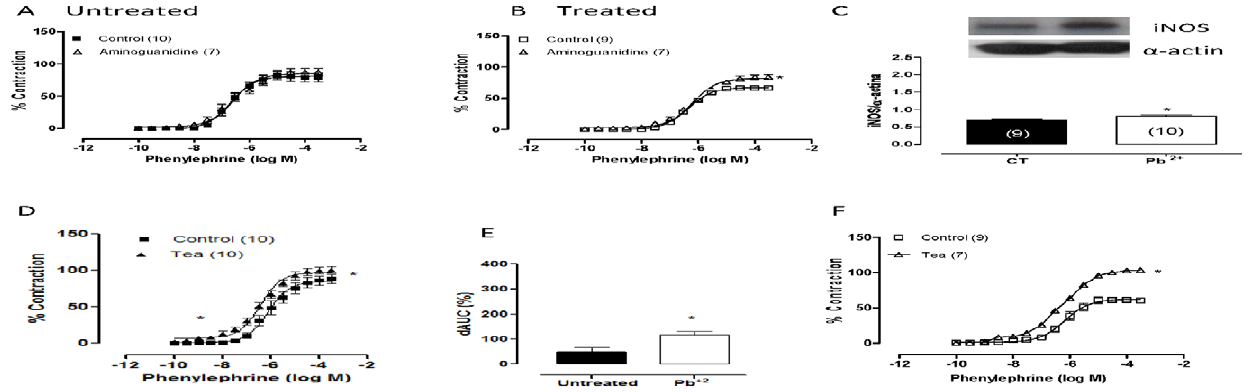
Figure 3. The effects of aminoguanidine (50 m M) (A, B) and TEA (2 mM) (D, E) on the concentration-response curves to phenylephrine in endothelium-intact aortic segments from untreated (CT) and lead-treated rats (Pb + 2 ). The inset shows differences in dAUC in the presence and absence of TEA (F). Densitometry analyses of western blots for inducible nitric oxide synthase (iNOS) protein expression in aortas from untreated (CT) and lead-treated rats (Pb + 2 ) (C). Representative blots are shown. *P , 0.05 by Student’s t- test. Number of animals used is indicated in parentheses.